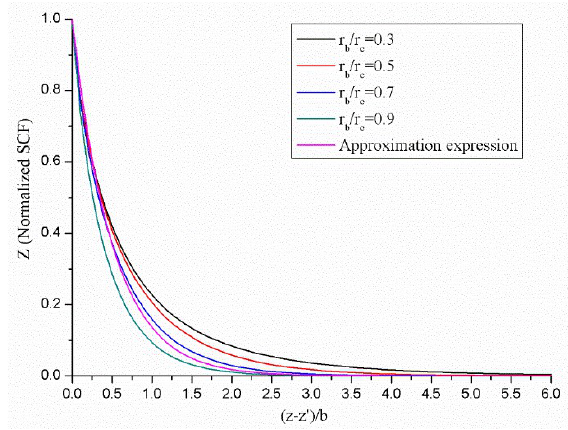
Figure 2. The curve of the SCF with respect to z-z’ in different